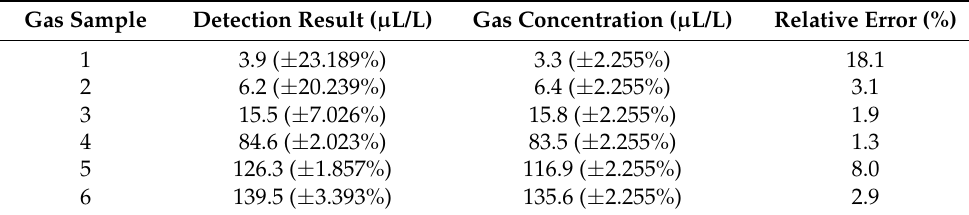
Table 2. Accuracy of detection system.